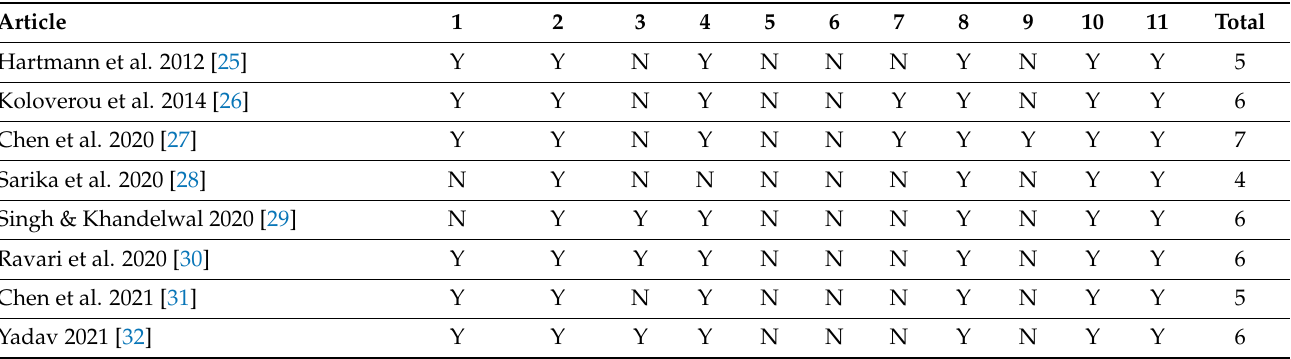
Table 1. Methodological quality of the articles